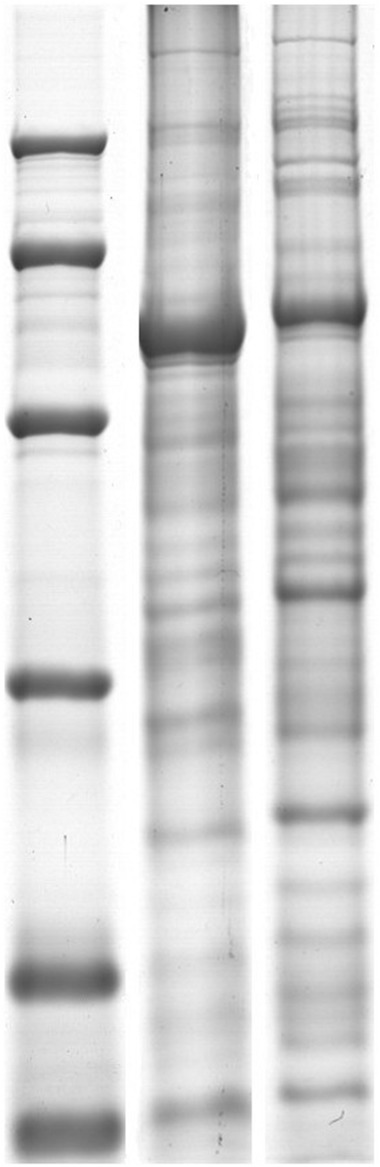
SDS-PAGE of contrast of holoproteins and low-abundant proteins. (A) Are holoproteins extracted by TCA/acetone. (B) Are low-abundant proteins extracted by PEG. 12.5% SDS-PAGE gel showing RuBisCO depletion. RuBisCO large subunit (LSU) and small subunit (SSU) are marked.